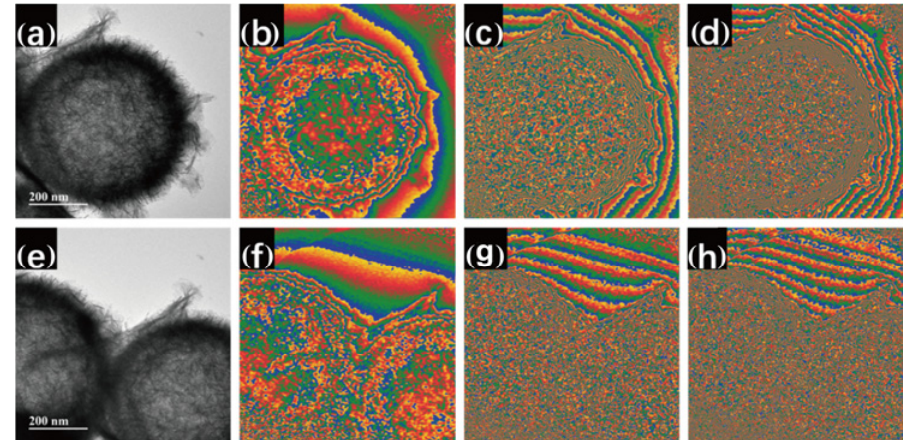
Fig. 8 (a, e) TEM images and corresponding off-axis electron holograms of (b–d) spatial potential and (f–h) charge density of SiO 2 @Ti 3 C 2 T x @CoNi